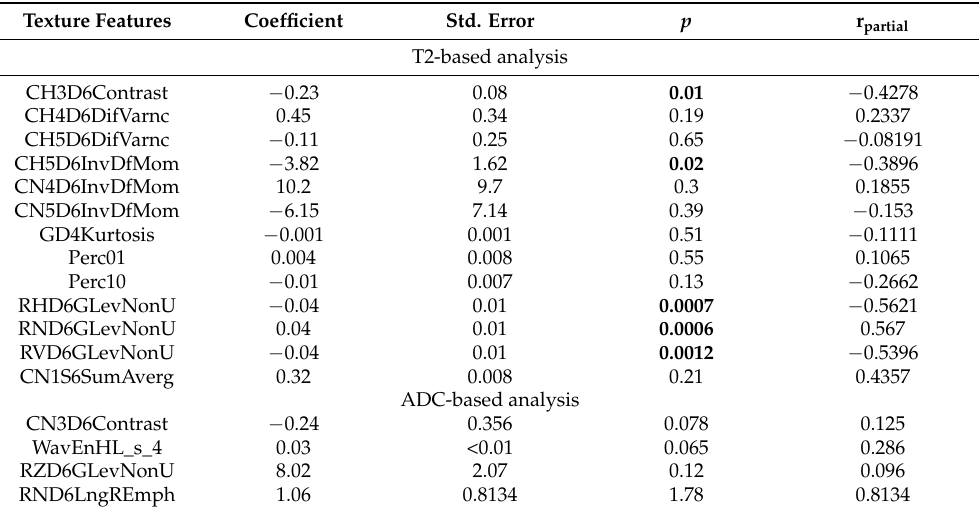
Table 4. Multivariate analysis results. Bold values indicate parameters that are able to independently predict mucinous cysts.